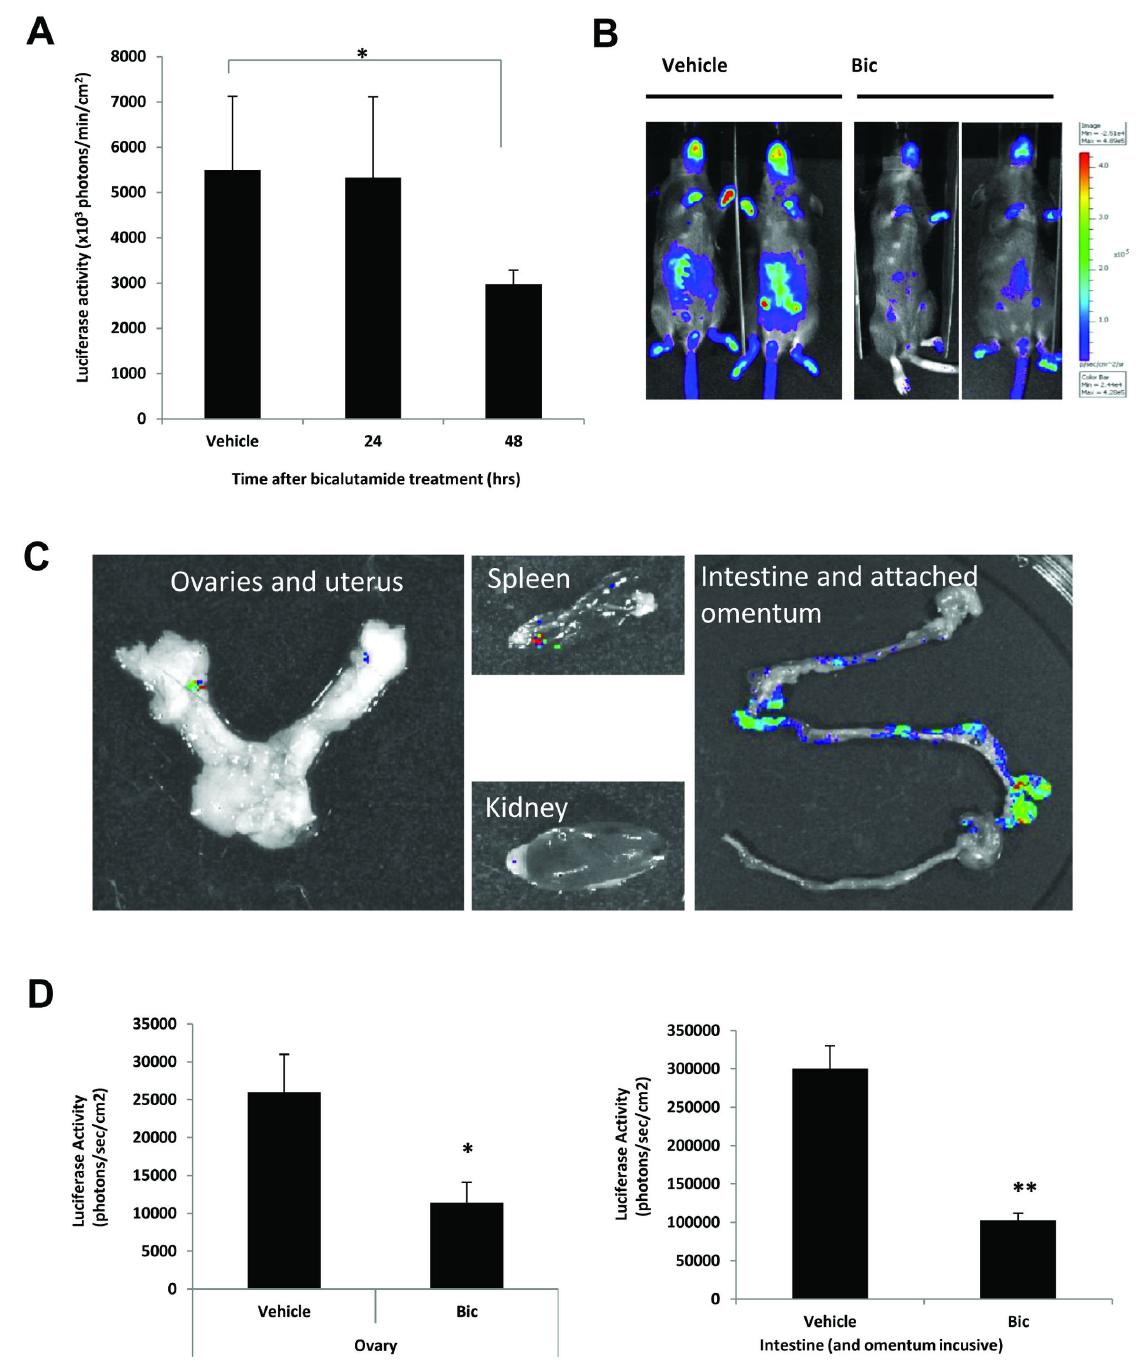
Figure 5. Bicalutamide treatment reduces androgen receptor activity in female mice. (A), Bioluminescent imaging of female mice treated with bicalutamide (50mg/kg) for 24 and 48 hours. Graph indicates measured bioluminescence signal from the abdominal region at the indicated timepoints, error bars represent the standard error from three mice. (B), representative bioluminescent image of vehicle and bicalutamide treated mice at 48hours. Figure represents a greyscale photograph overlaid with a pseudocolour representation of bioluminescence; scale represents photons/sec/cm 2 . (C), panel showing ex vivo imaging of the organs from bicalutamide treated mice after 48hours (intestines image not to scale). (D), Bioluminescence signal from the ovaries and the intestines taken ex vivo, from female mice treated for 48hours with vehicle or bicalutamide. Error bars represent the standard error from three mice, **P<0.01, *P<0.05 (t-test analysis). doi: 10.1371/journal.pone.0071694.g005 PLOS ONE |